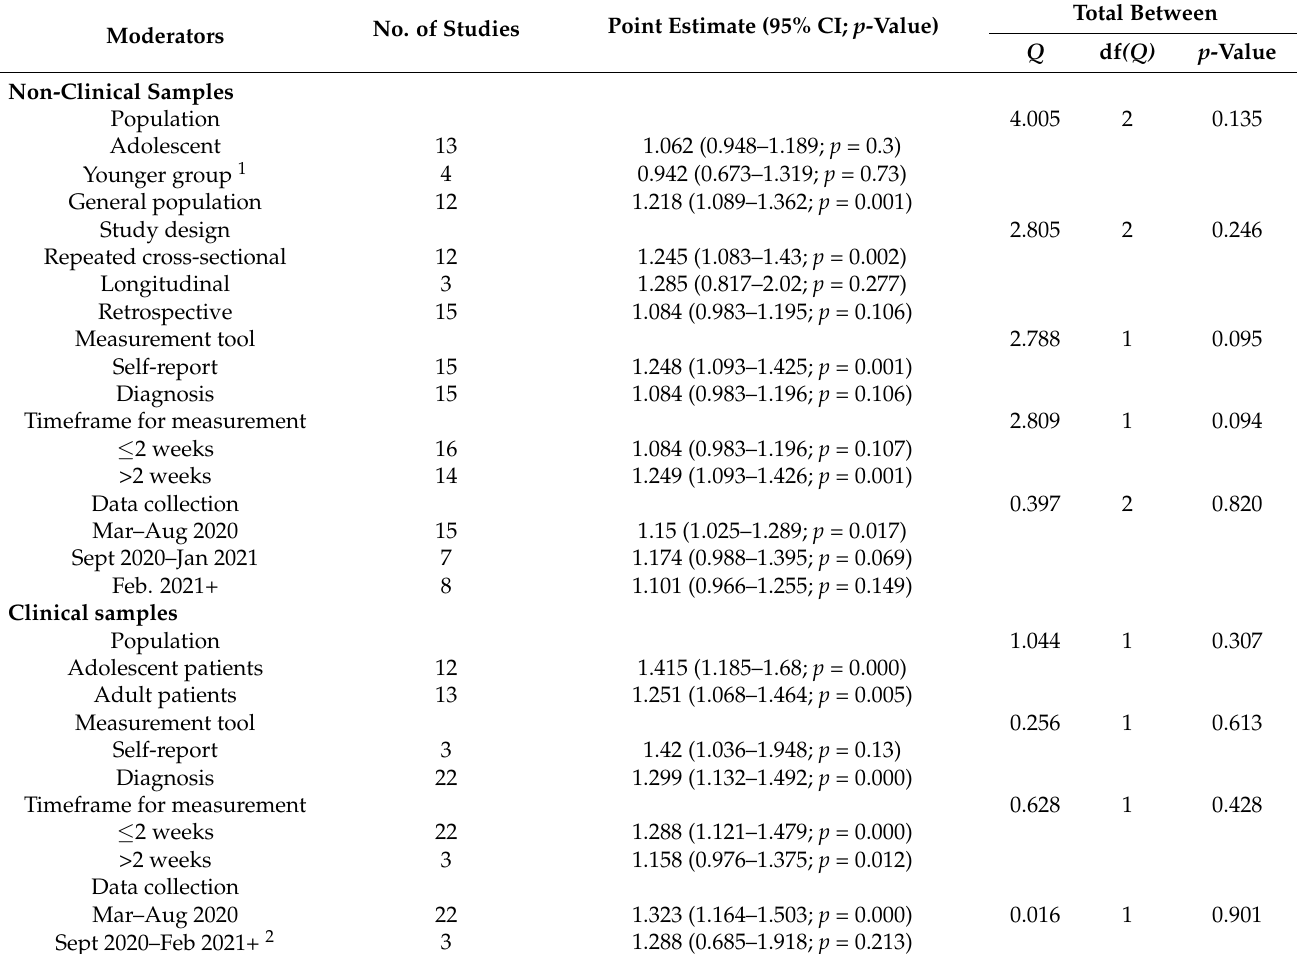
Table 6. Summary of subgroup analysis for non-clinical and clinical samples reporting suicide